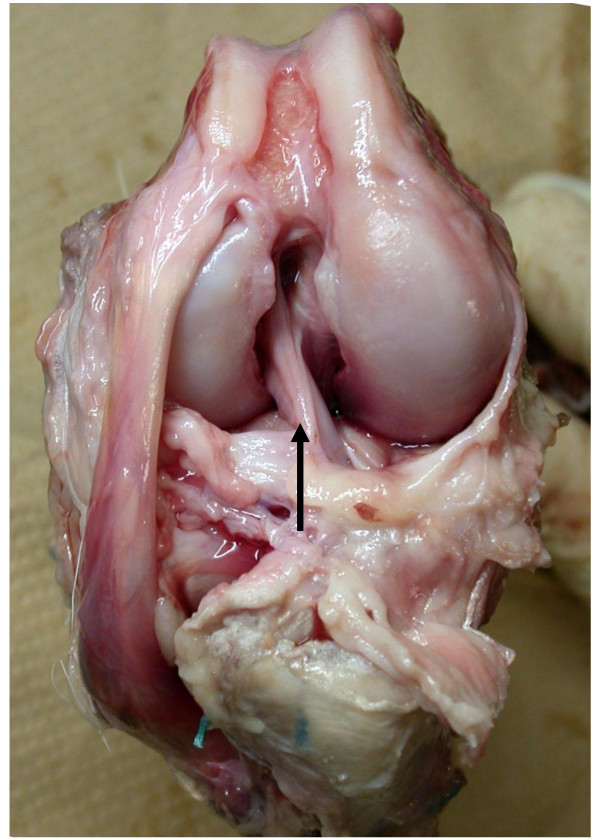
Two years after ACL reconstruction. The ACL replacement graft remained (arrow).